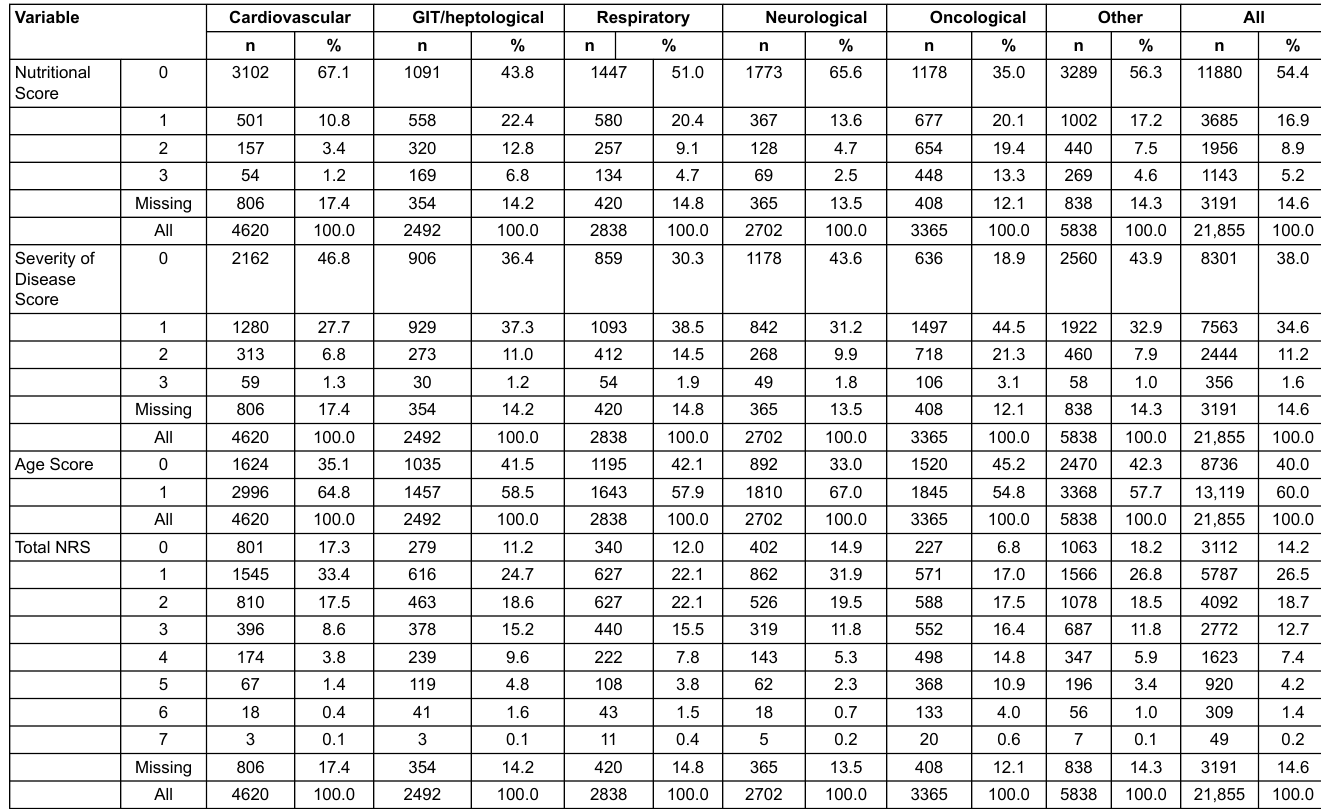
Table S1: Distribution of NRS-2002 scores and their components by diagnosis